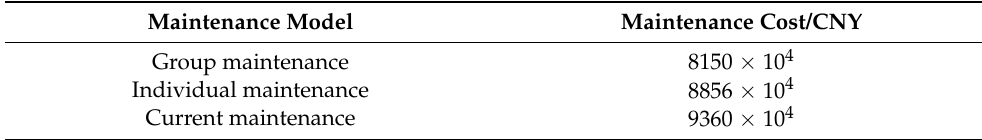
Table 7. The total cost comparison results of multi-component maintenance models.